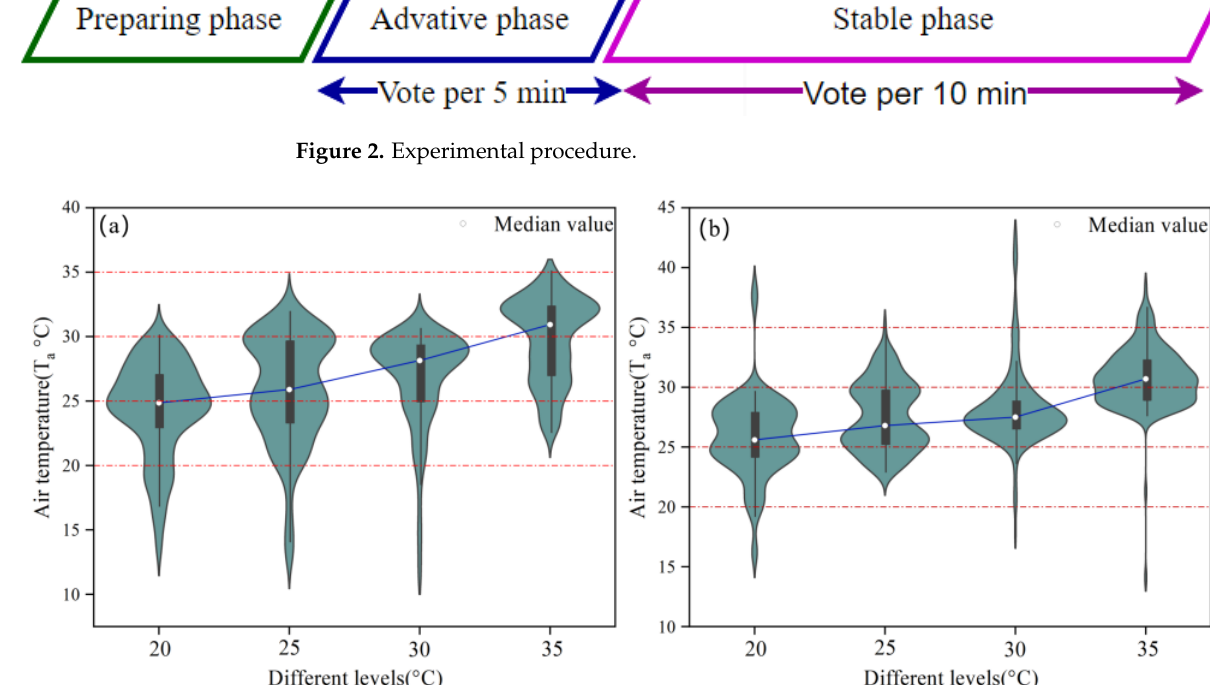
Figure 3. Disturbution of air temperature in different condition levels: ( a ) radiant and ( b ) convective heating.